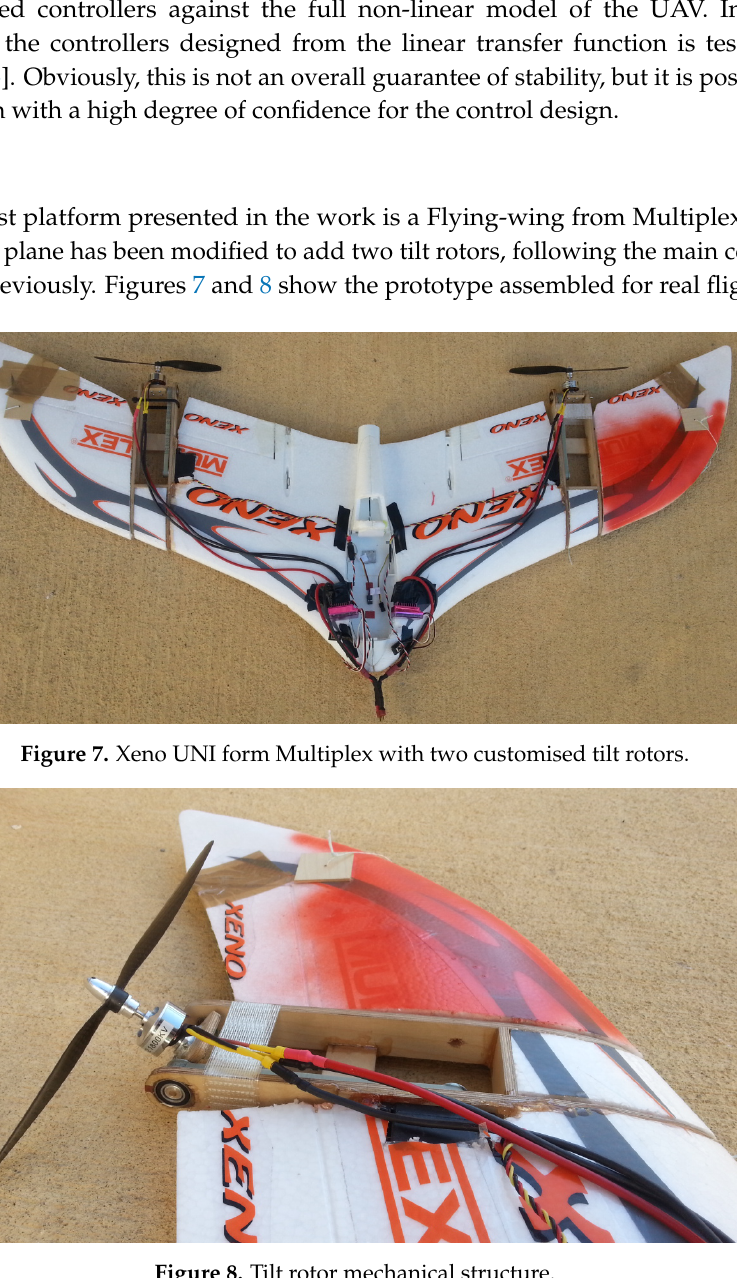
Figure 8. Tilt rotor mechanical